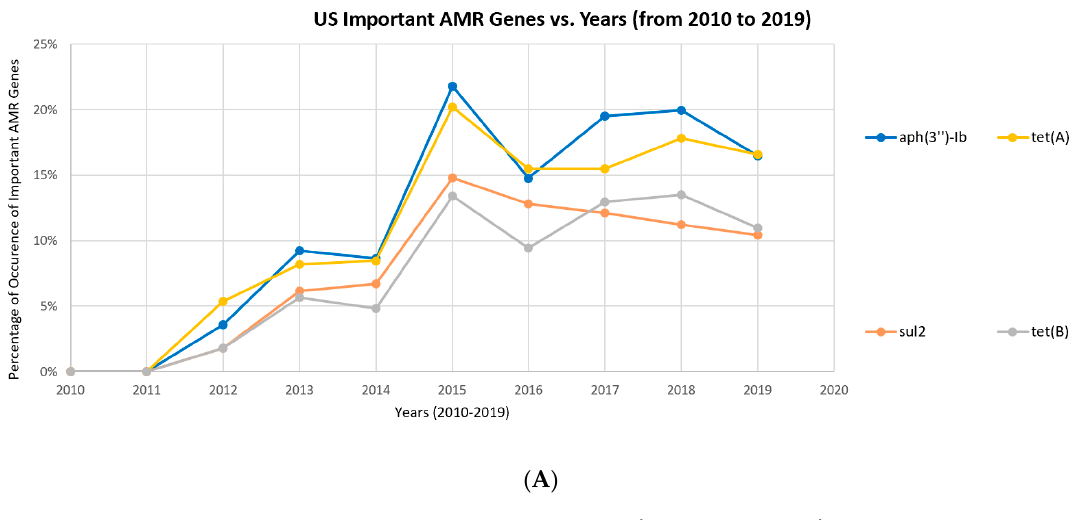
Figure 7. ( A ) projections of South Africa, Mexico, Canada, the UK, the US, Brazil, China, and Australia onto the PC1-PC2 space based on the occurrence of foodborne pathogens shown in Table 3; ( B ) clustering the countries based on their projections in ( A ).